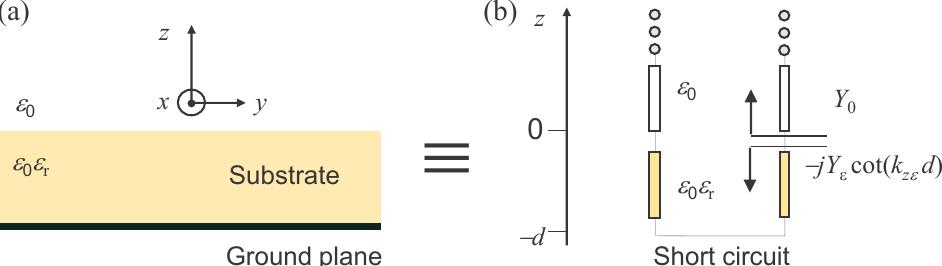
Figure 3. ( a ) One-dimensional section of the backmetallized substrate under test and ( b ) its transmission-line equivalent